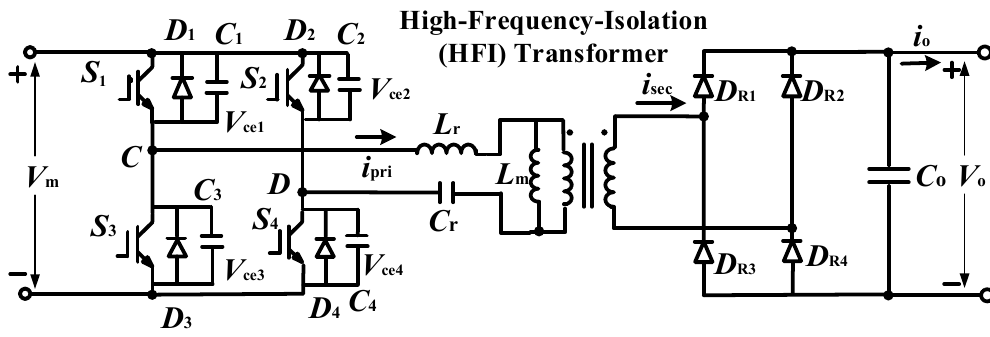
Figure 9. Back-end HFI LLC resonant converter.